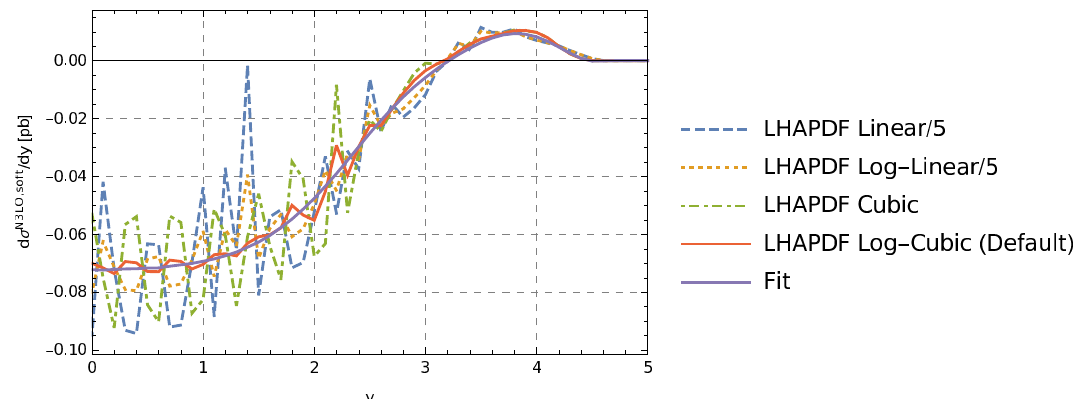
Figure 5. Soft-virtual term of the N3LO correction to the absolute rapidity distribution evaluated with various ways of interpolating the PDF grid. The blue line is obtained using a linear interpolator, the yellow line was obtained using a log-linear interpolator, the green line was obtained using a cubic interpolator. The solid orange line was obtained using the default LHAPDF setting, which uses a log-cubic interpolator. The solid purple line was obtained using our custom (cid:12)t to the LHAPDF grid, which is described in the text. Note that the excursions of the blue and yellow line from the central value obtained through the (cid:12)t were divided by a factor of (cid:12)ve to be able to visualize the